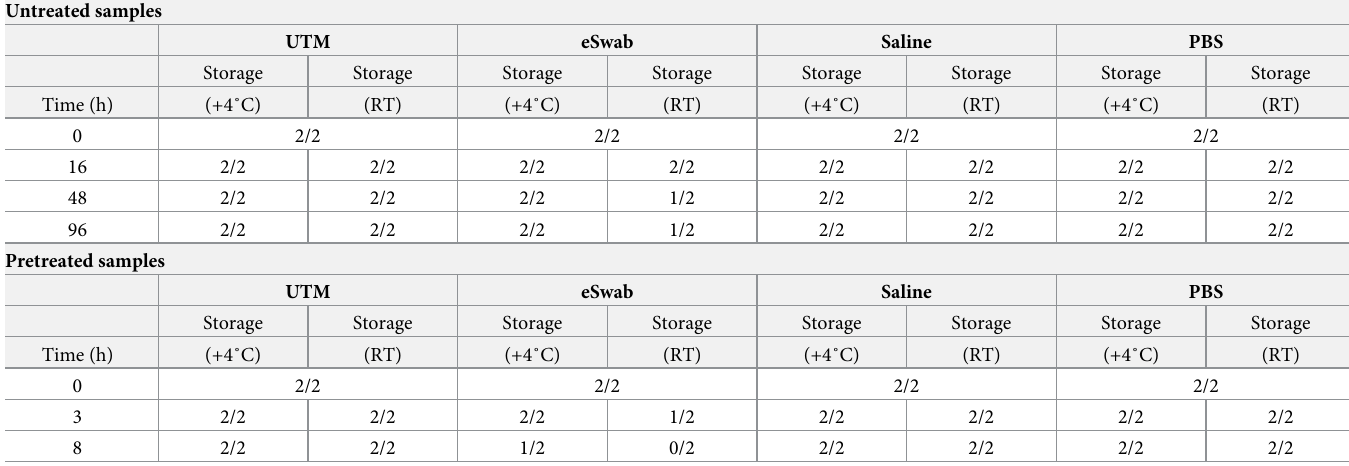
Table 3. Sample stability in various transport media for untreated and pretreated samples used for the GenomEra SARS-CoV-2 assay. Untreated samples